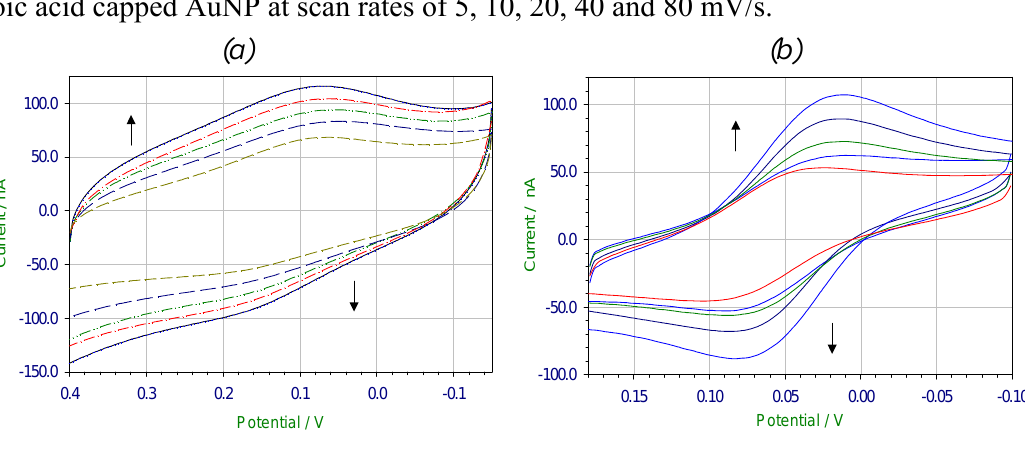
Figure 6. Cyclic voltammogram of HRP coupled to (a) glutathione capped AuNP, (b) lipoic acid capped AuNP at scan rates of 5, 10, 20, 40 and 80